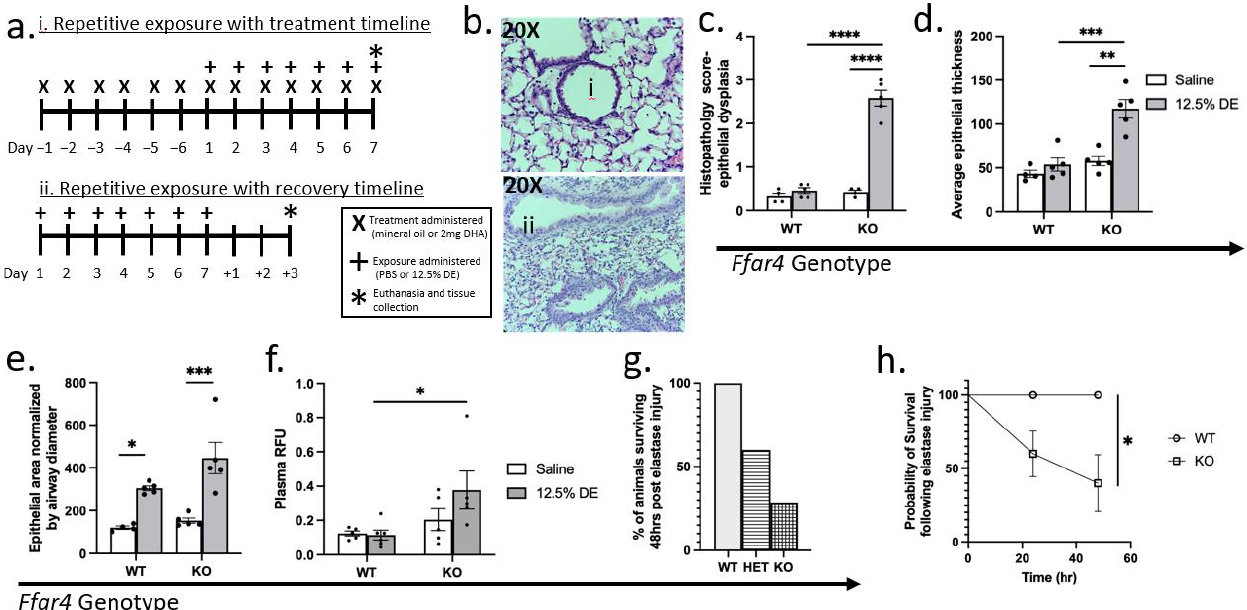
Figure 3. Lack of Ffar4 impairs airway epithelial barrier homeostasis. ( a ) Schematic of repetitive exposure timeline without ( i ) and with ( ii ) the recovery period. The recovery studies did not include treatments, and mice were left to recover without exposure for three days. On the third day of recovery, 1 h before euthanizing, mice were given intranasal RhoB-dextran in PBS. X’s represent oral gavage treatments with mineral oil (vehicle control) or 2 mg DHA, plus signs (+) represent the administration of intranasal exposure (PBS or 12.5% DE), and the asterisk (*) signifies euthanasia. If euthanasia fell on the day of an exposure, animals were euthanized 5 h after administration. ( b ) H & E-stained FFPE lung sections reveal a dysplastic epithelial appearance (representative images of ( i ) normal and ( ii ) dysplastic epithelium at 20×). Ffar4 -deficient mice exposed to DE had significantly higher airway epithelial dysplasia scores compared with DE-exposed WT and naïve KO mice (( c ), Adj. p < 0.0001 for each), and similar findings were observed in quantified epithelial thickness (( d ), Adj. p = 0.0001 and 0.0002, respectively). Airway area normalized to diameter was only significant in both dust-exposed WT and KO mice compared with their respective genotype-matched saline controls (( e ), Adj. p = 0.0285 and 0.004 respectively). ( f ) Using intranasal Rhodamine B dextran delivery, Ffar4 -deficient mice had significantly greater plasma fluorescence following repetitive instillations of DE plus three days for repair (Adj. p = 0.0081). ( g , h ) Ffar4 -deficient mice had significantly reduced survival in an acute epithelial injury model of a single dose of intranasal porcine pancreatic elastase (( h ), Log-rank test, p = 0.0224). ** p < 0.01; **** p < 0.001.; **** p <